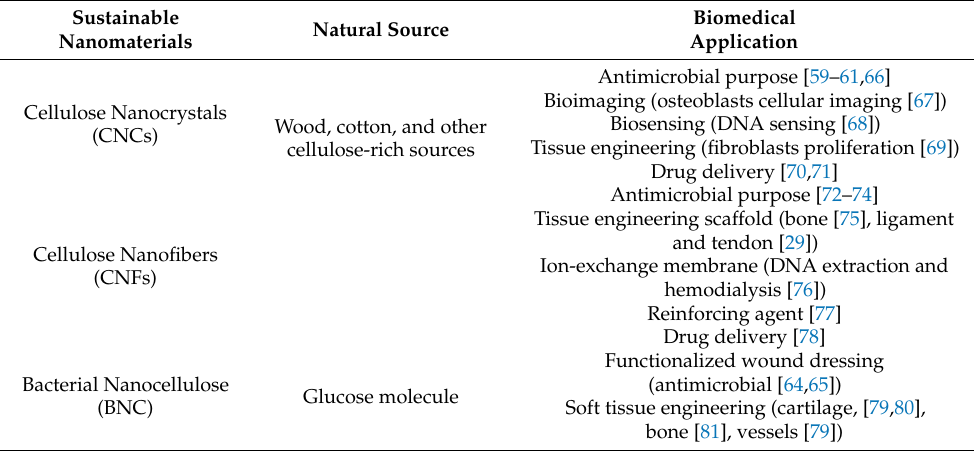
Table 2. Summary of nanocellulose material for biomedical